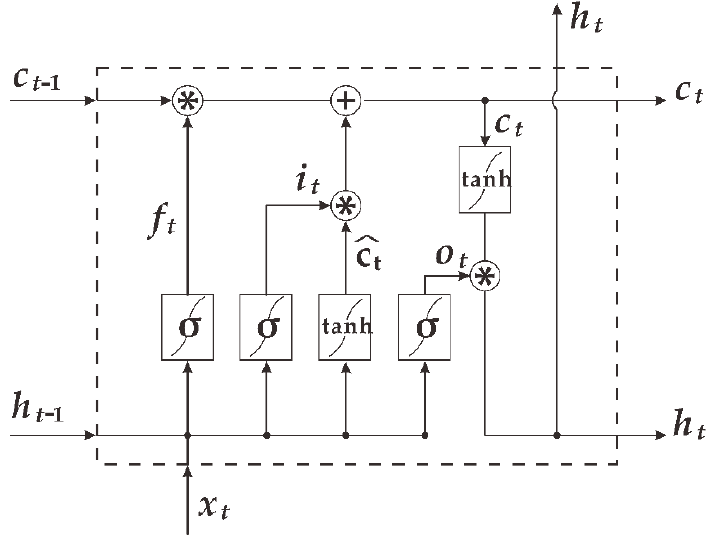
Figure 1. Structural comparison between the artificial neural network (ANN) and recurrent neural network (RNN); ANN on the left is an independent structure, and RNN on the right is an interconnected structure.